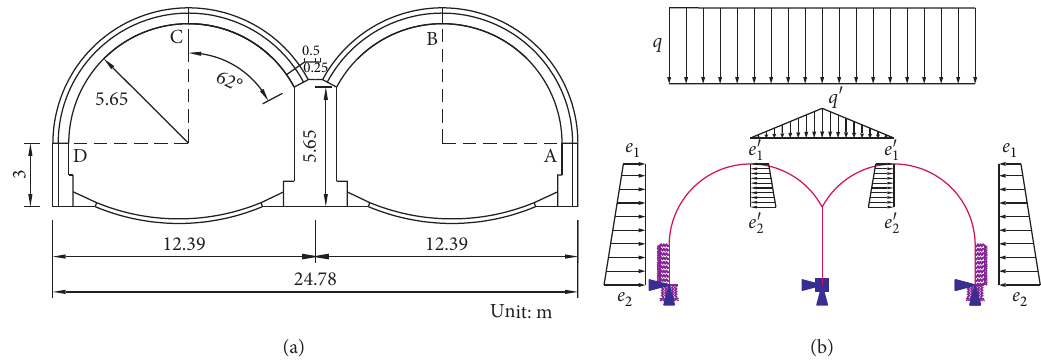
Figure 8: The adopted model of double-arched tunnel: (a) the cross section of the model (adapted from [10]); (b) the 2D FEM